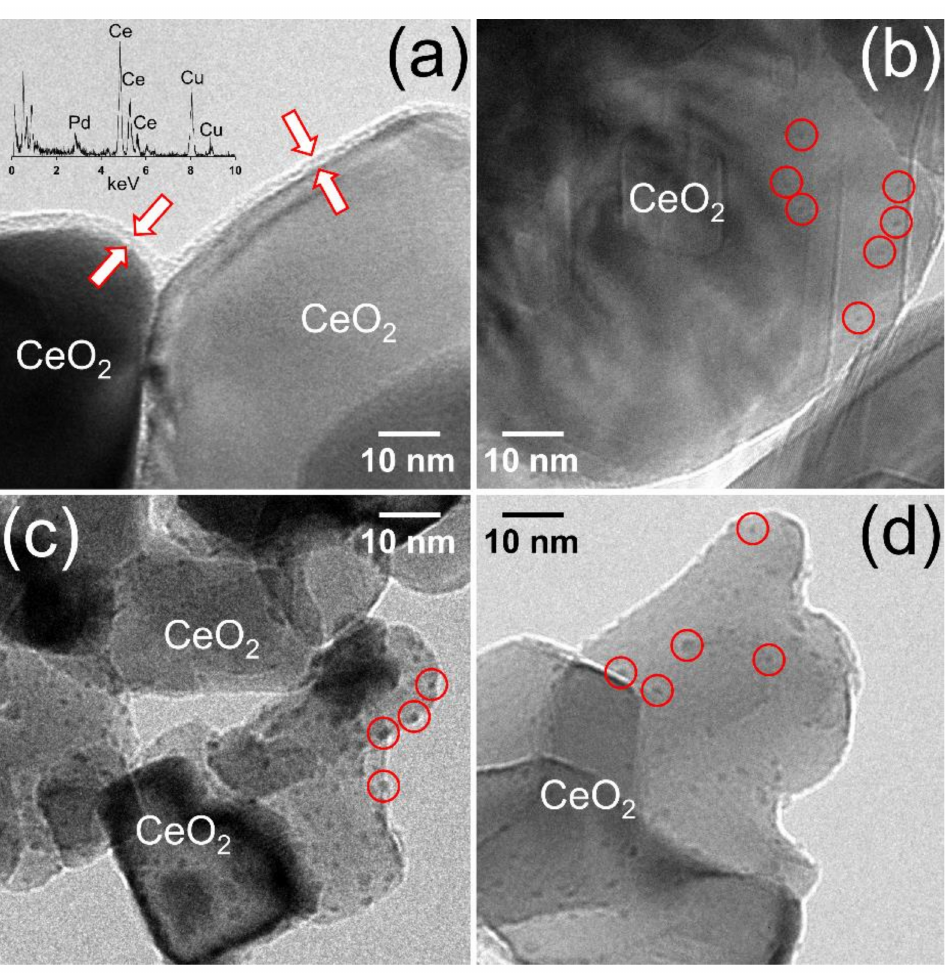
Figure 1. HRTEM images of the Pd/CeO 2 catalysts prepared by milling CeO 2 and Pd acetate ( a ) or Pd nitrate ( b ) at 50 Hz for 10 min, and catalysts prepared by incipient wetness impregnation with Pd acetate ( c ) or Pd nitrate ( d ). All catalysts contain a nominal Pd loading of 1